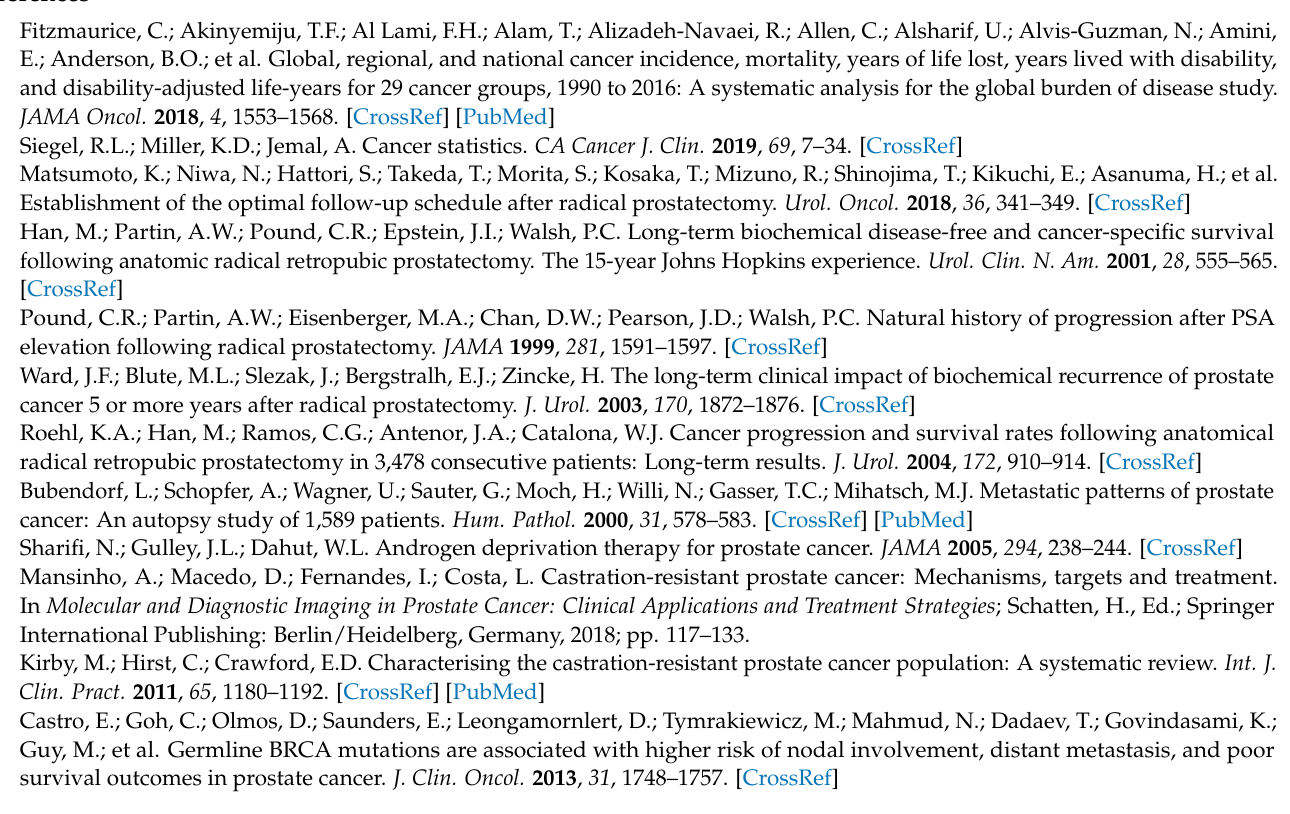
different cohorts, Figure S10: Functional enrichment analysis of the CRPCPS, Table S1: Characteristics of gene expression datasets used for the identification of differentially expressed genes, Table S2: Differentially expressed genes (DEGs) between localized CRPC and HSPC samples with |log2 (fold change)| > 0.5 and p value < 0.05 by RRA analysis. CRPC-associated genes newly identified in our study were marked in bold, Table S3: List of the 24 genes that were significantly associated with recurrence-free survival (RFS) in the TCGA training cohort ( p -value < 0.05), as analyzed by the univariate Cox regression analysis, Table S4: Characteristics of the three CRPCPS-derived genes and their coefficients used for predicting CRPC